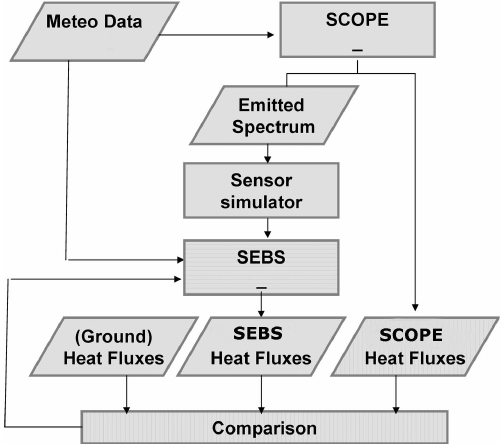
Fig. 1. Methodology for comparing SEBS with